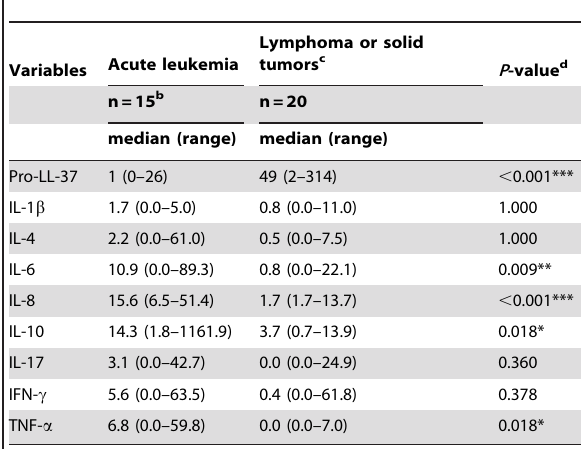
Table 4. Multivariable logistic regression with oral mucositis as the outcome in all patients (n =104).